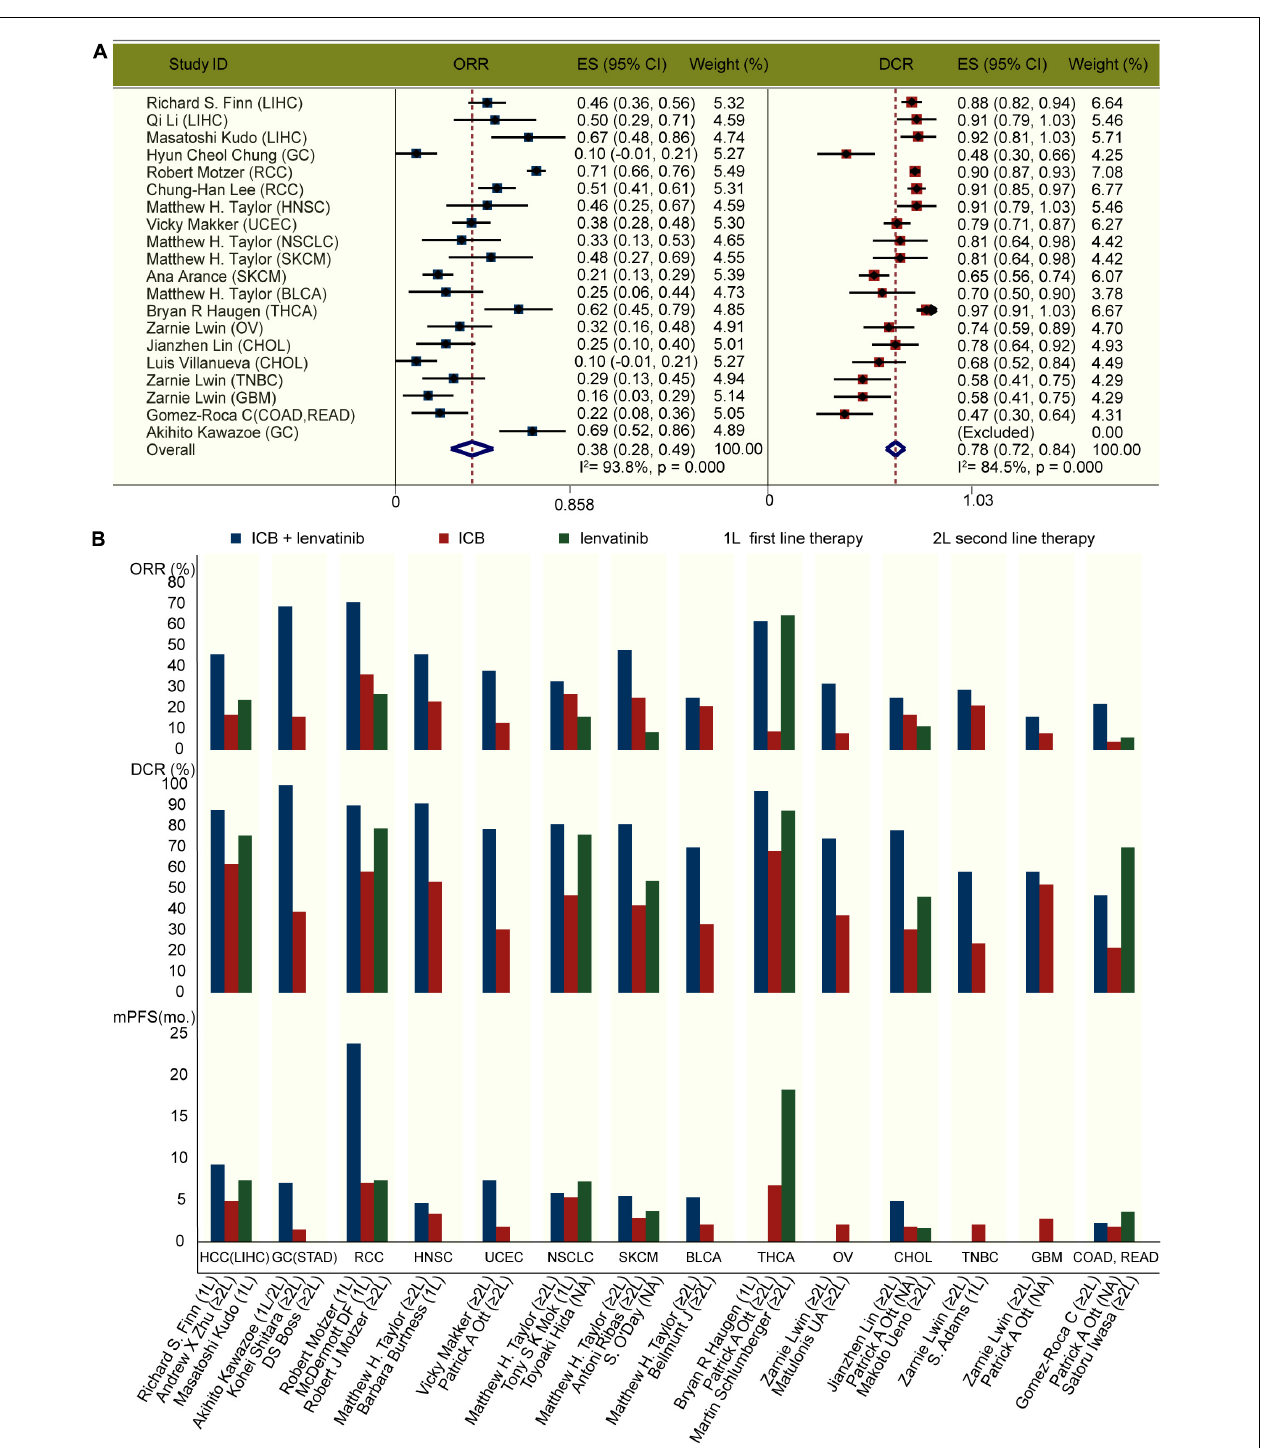
FIGURE 1 | Clinical outcomes with ICB and lenvatinib. (A) Forest plot analysis of ORR and DCR with ICB combined with lenvatinib across different cancer types. (B) ORR, DCR, and mPFS with pembrolizumab and lenvatinib combined or as monotherapy across different cancer types. 1L, first line therapy; 2L, second line therapy; BLCA, bladder urothelial carcinoma; CHOL, cholangiocarcinoma; COAD, colon adenocarcinoma; ES, effect size; GBM, glioblastoma multiforme; GC, gastric cancer; HNSC, head and neck squamous cell carcinoma; LIHC, liver hepatocellular carcinoma; mo., month; NSCLC, non-small-cell lung cancer; OV, ovarian serous cystadenocarcinoma; RCC, renal cell carcinoma; READ, rectum adenocarcinoma; SKCM, skin cutaneous melanoma; THCA, thyroid carcinoma; TNBC, triple-negative breast carcinoma; UCEC, uterine corpus endometrial carcinoma.